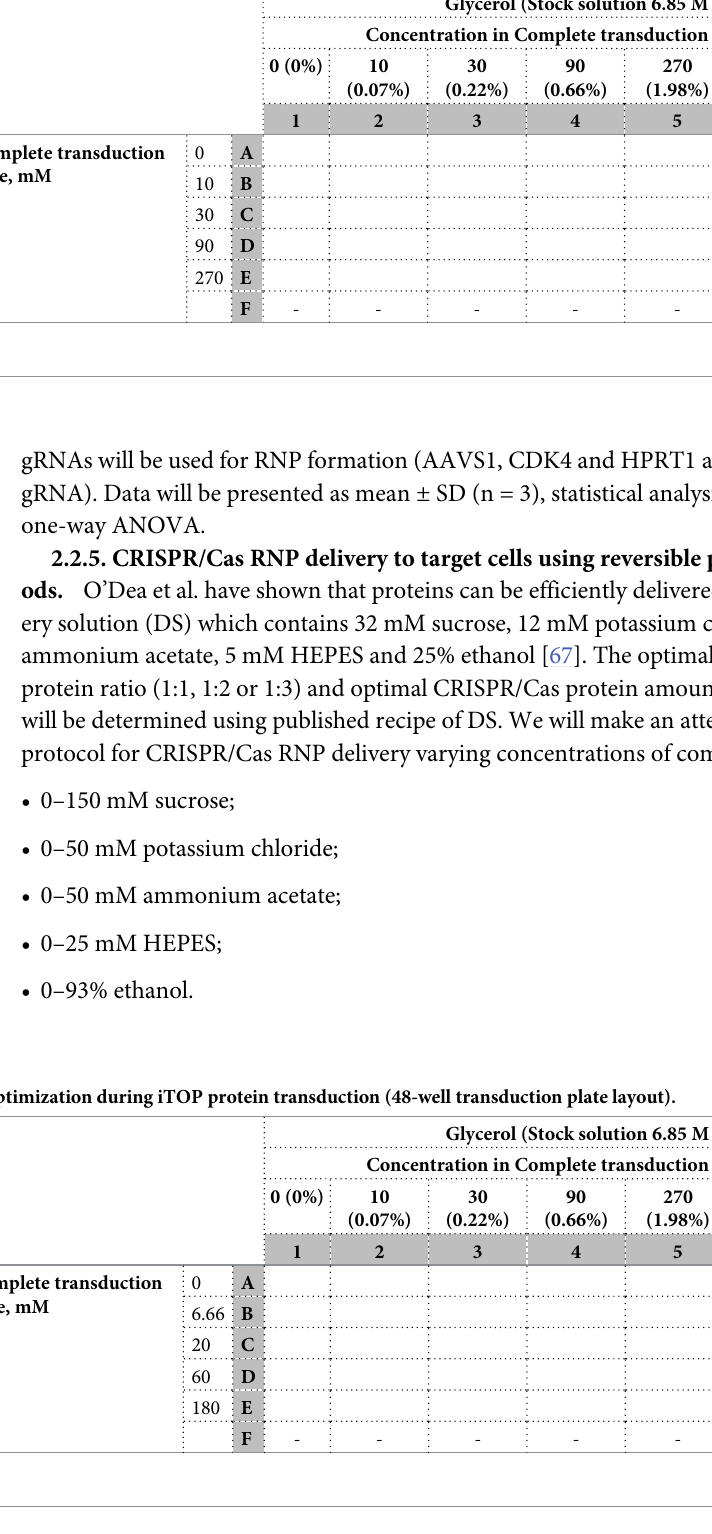
Table 5. Betaine and glycerol concentrations optimization during iTOP protein transduction (48-well transduction plate layout).